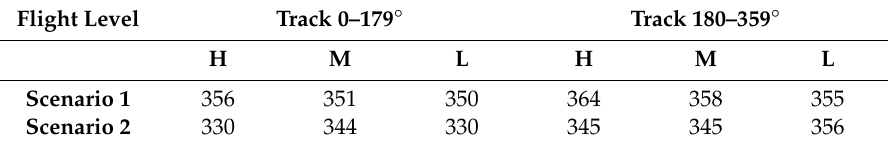
Table 6. Average flight levels for each wake vortex class and semicircular cruising level direction.